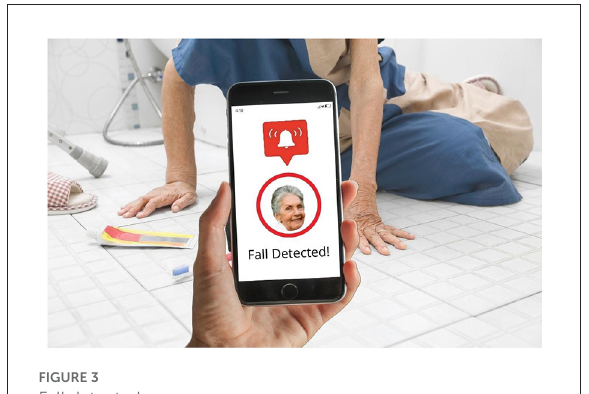
FIGURE3 Fall detected.